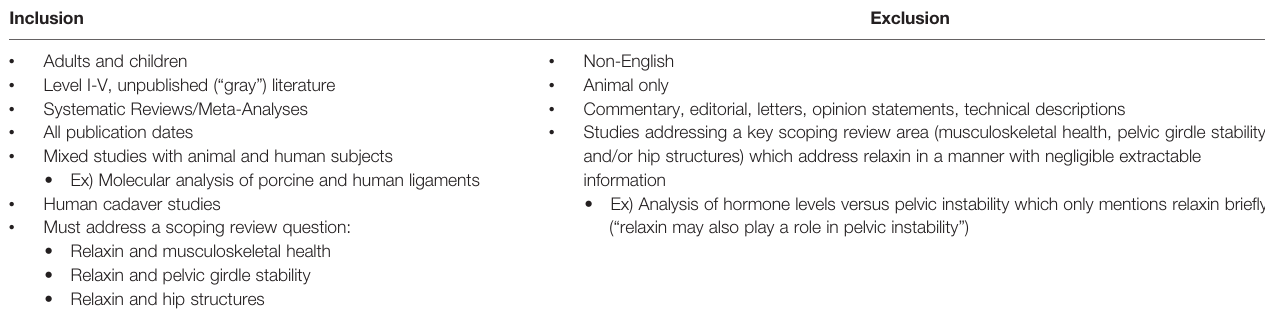
TABLE 1 | Scoping review screening, inclusion and exclusion